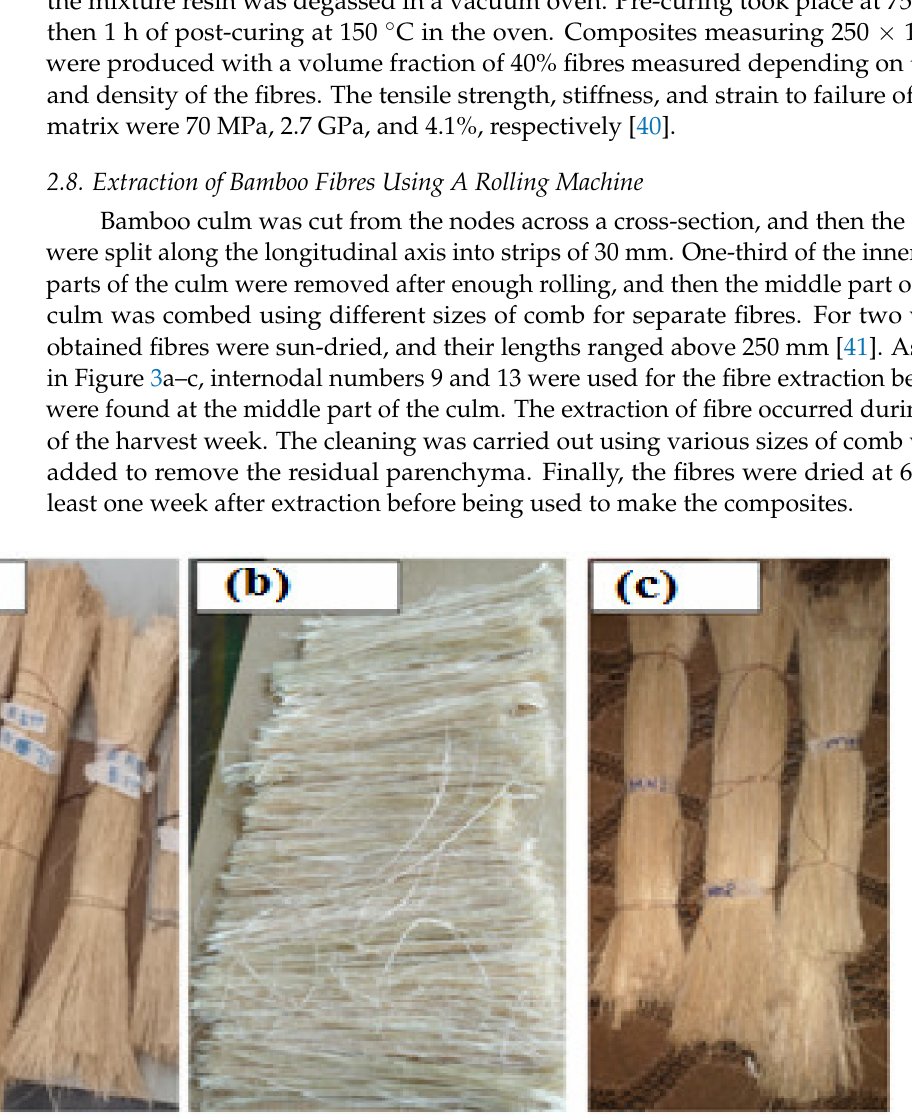
Figure 3. Extracted bamboo fibres: ( a ) Injibara, ( b ) Kombolcha, and ( c )